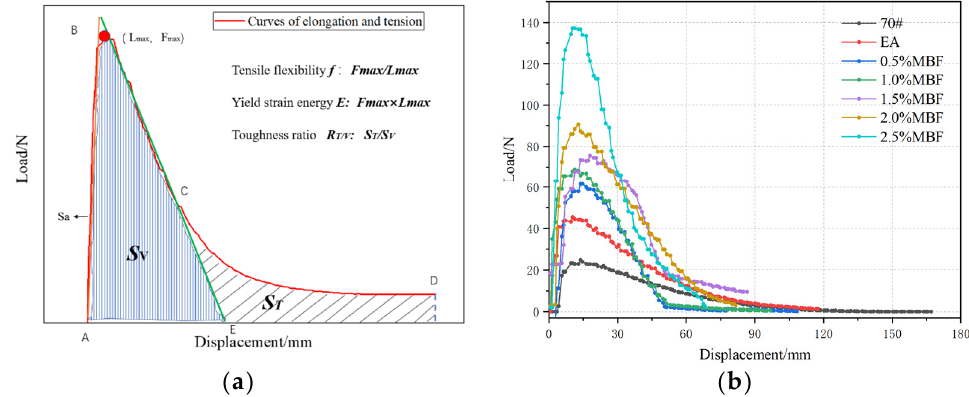
Figure 14. Force ductility diagram of coupling-modified BF evaporation residue at 5 °C: ( a ) tension—ductility indicator diagram; ( b ) tensile—elongation force curve.